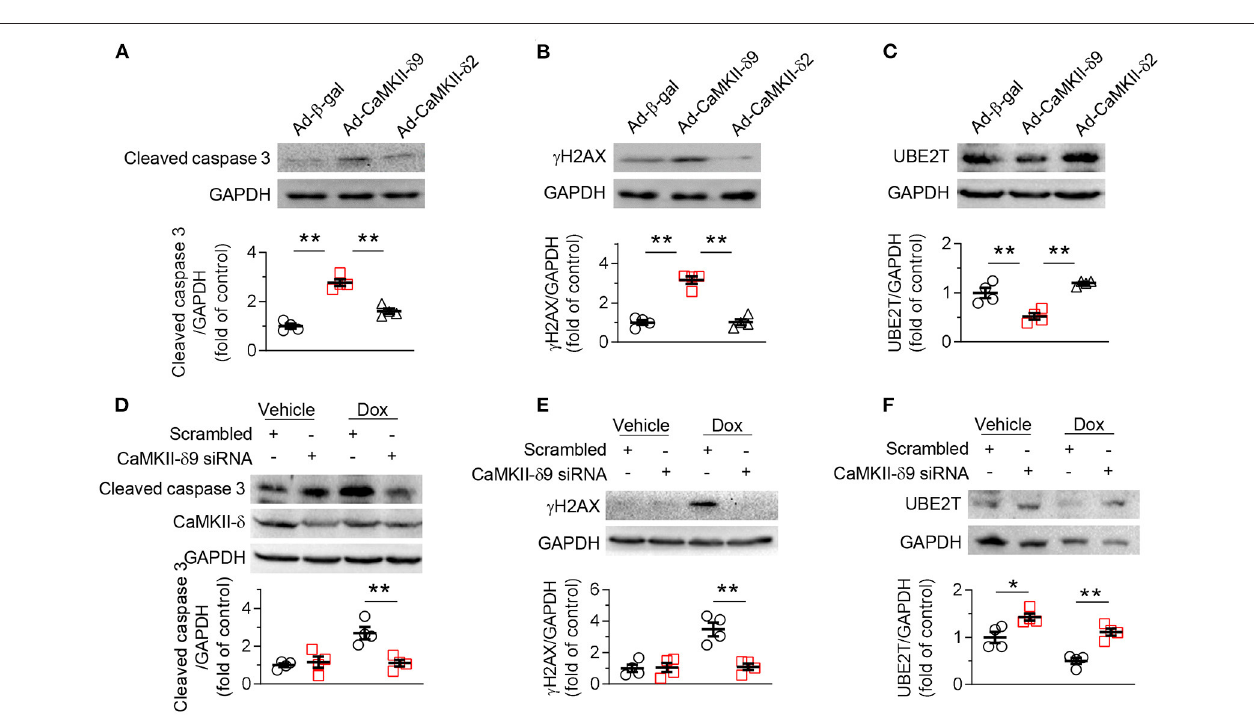
FIGURE 5 | CaMKII- δ 9 mediates DNA damage and cell death in adult cardiomyocytes. (A–C) Representative western blots and statistical data showing the levels of cleaved caspase 3 (A) γ H2AX (B) and UBE2T (C) in adult rat ventricular myocytes (ARVMs) infected with Ad- β -gal, Ad-CaMKII- δ 9, or Ad-CaMKII- δ 2 (100 MOI, 24h) ( n = 4). (D–F) Representative western blots and statistical data showing the levels of cleaved caspase 3 (D) , γ H2AX (E) and UBE2T (F) in ARVMs infected with scrambled or CaMKII- δ 9 siRNA with or without Dox treatment (1mM, 16h) ( n = 4). Data are mean ± S.E.M. * P < 0.05, ** P < 0.01; one-way ANOVA (A–C)